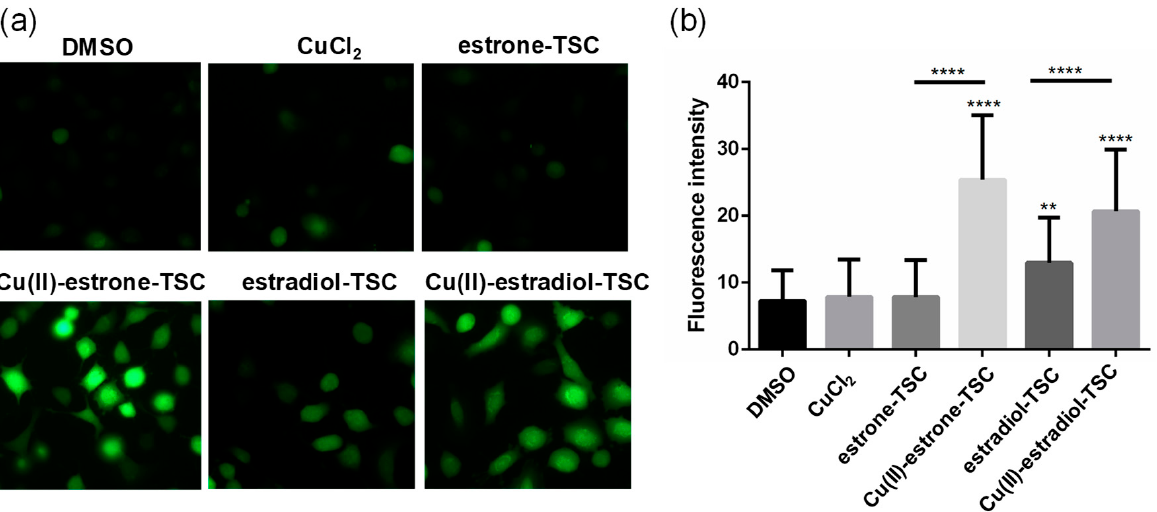
Figure 11. ( a ) Representative fluorescence microscopic images show the DCFDA staining to deter ‐ mine ROS levels in A549 cells upon the treatment with estrone ‐ TSC and estradiol ‐ TSC and their Cu(II) complexes (20 μ M) in addition to the DMSO blank (90% DMSO and 10% PBS) and CuCl 2 (20 μ M) as indicated in the figure using 6 h incubation time. ( b ) Level of ROS generation measured by DCFDA staining on A549 cells. (**: p < 0.01; ****: p < 0.001).